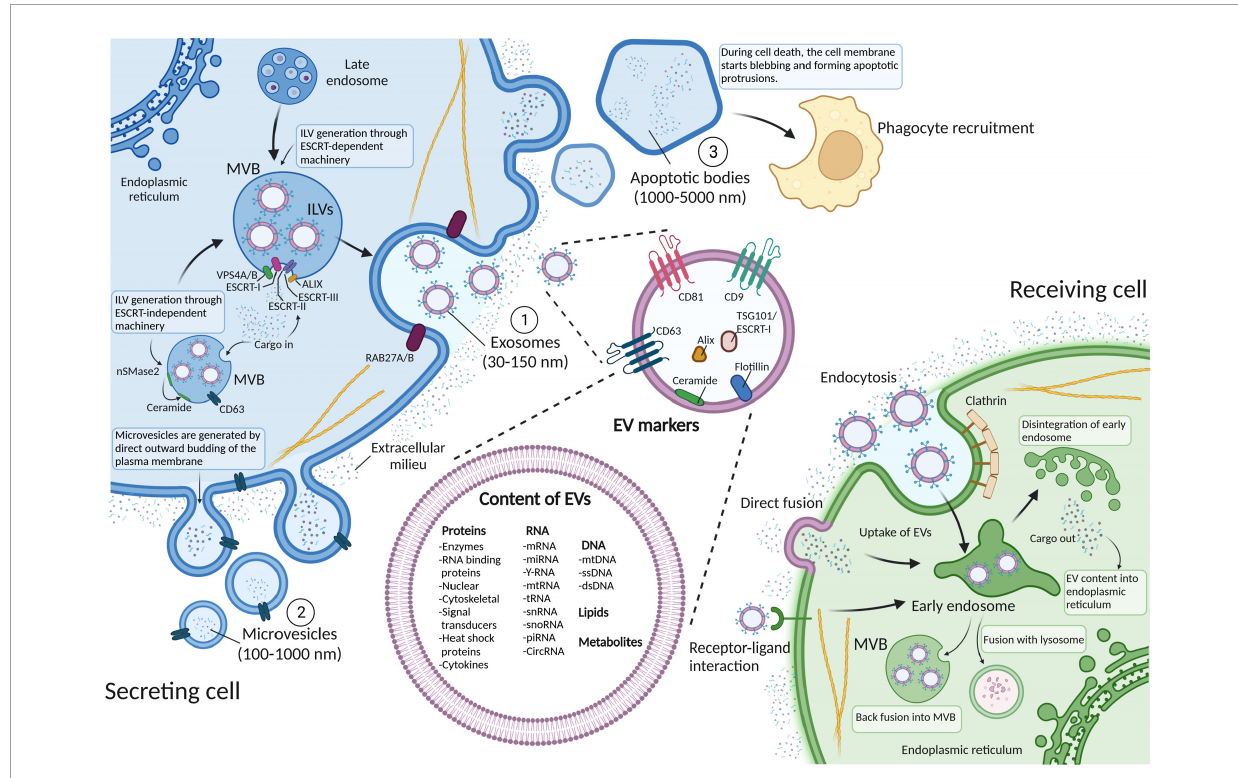
FIGURE1 Schematic representation of biogenesis, release, and internalization of extracellular vesicles (EVs), along with markers used for EV identification. The three subtypes of EVs are generated through three different biogenesis pathways. (1) Exosomes (30–150 nm) are generated via the endosomal pathway through mechanisms that can be either endosomal sorting complex required for transport (ESCRT)-dependent or -independent. These mechanisms orchestrate the invagination of intraluminal vesicles (ILVs) within the multivesicular body (MVB), before being fused with the plasma membrane and released into the extracellular space. (2) Microvesicles (100–1,000 nm) are produced when the plasma membrane buds outward, detaches, and becomes a vesicle. (3) Apoptotic bodies (1,000–5,000 nm) appear after the disassembly of an apoptotic cell into subcellular fragments and are removed through macrophage recognition of plasma membrane markers followed by phagocytosis. Both exosomes and microvesicles can transfer their cargoes to the recipient cells via endocytosis, direct fusion and receptor ligand interaction. EVs that are taken up can then either get degraded by lysosomes or fuse with pre-existing early endosomes and subsequently disintegrate and release their contents into the endoplasmic reticulum or form MVBs again. EV surface proteins include tetraspanins, integrins and immunomodulatory proteins, whereas their cargo can instead contain different types of cell surface proteins, intracellular protein, RNA, DNA, lipids, and metabolites. Figure created with BioRender.com.